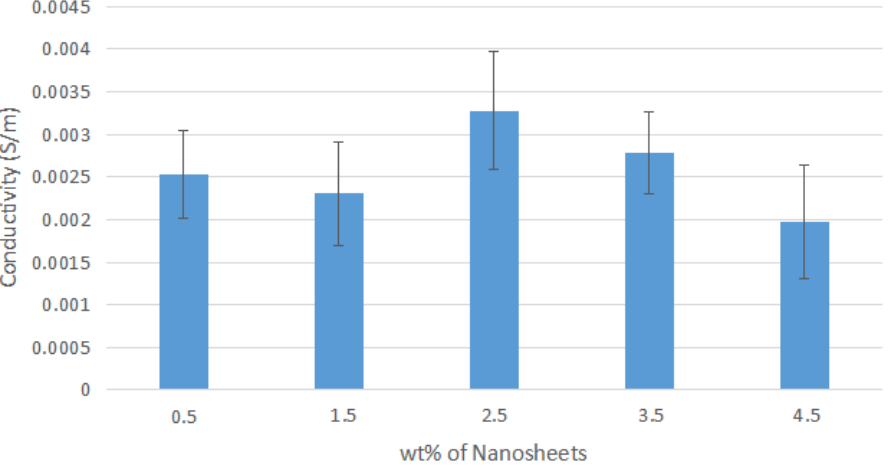
Figure A3. Average Conductivity of Nylon 610 Nanocomposites with Nanosheets Treated at 150 °C and − 0.1 MPa.